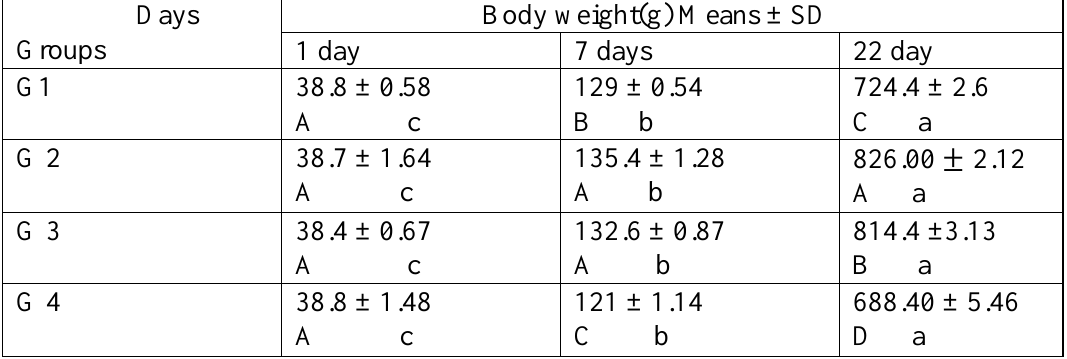
Table-2: Effect of different percentage of β-glucan extract on body weight . Days Groups